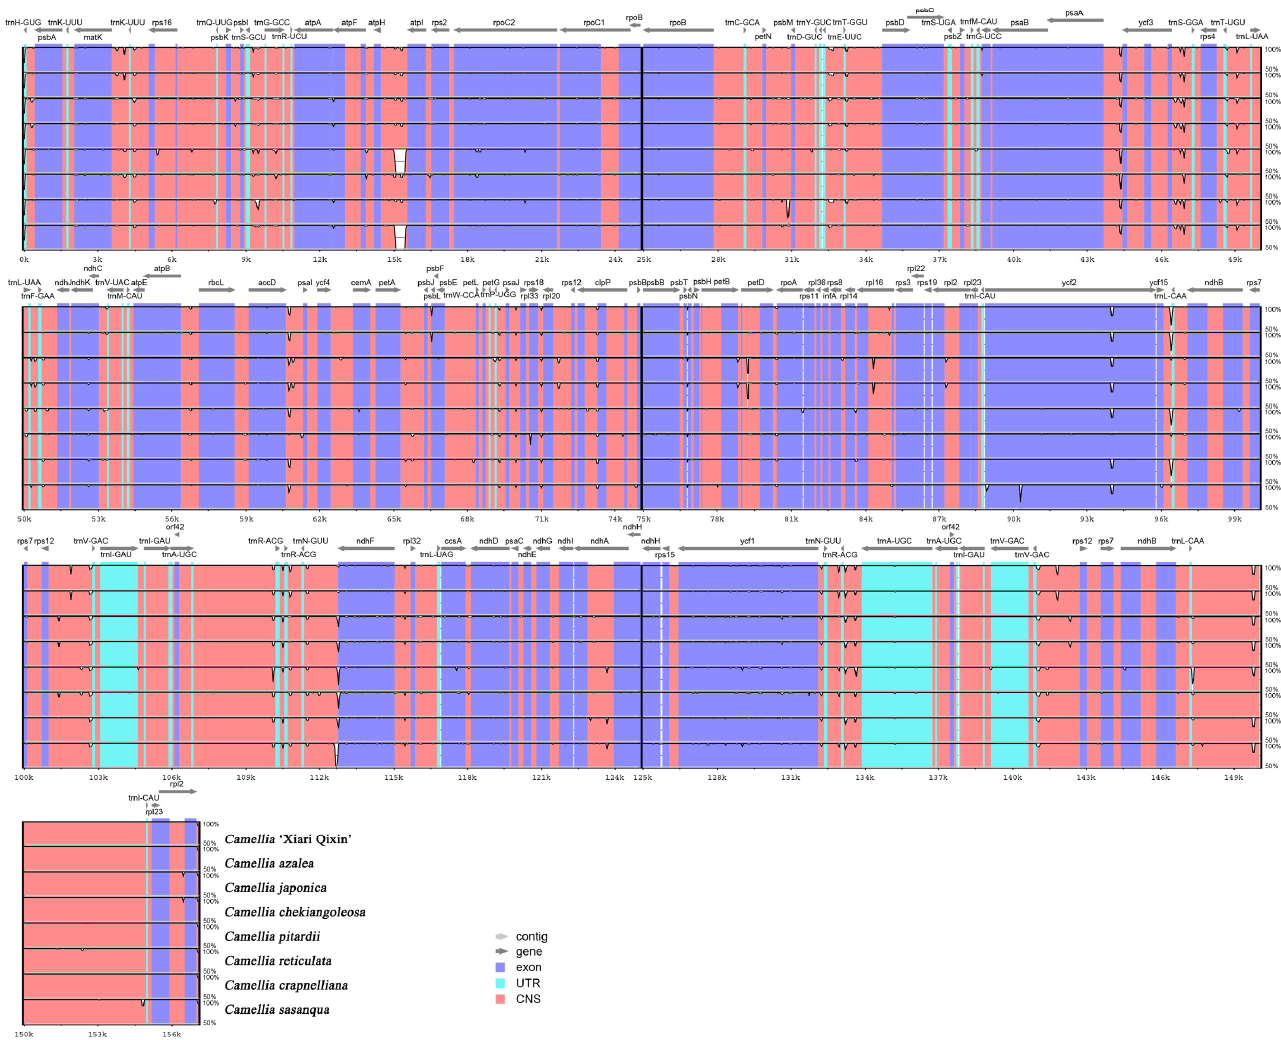
Figure 3. Global alignment of chloroplast genomes for C . ‘Xiari Qixin’ and seven Camellia species. The vertical scale represents the degree of identity, ranging from 50% to 100%. Coding and non-coding regions are colored in blue and red, respectively. Gray arrows indicate the position and direction of each gene.